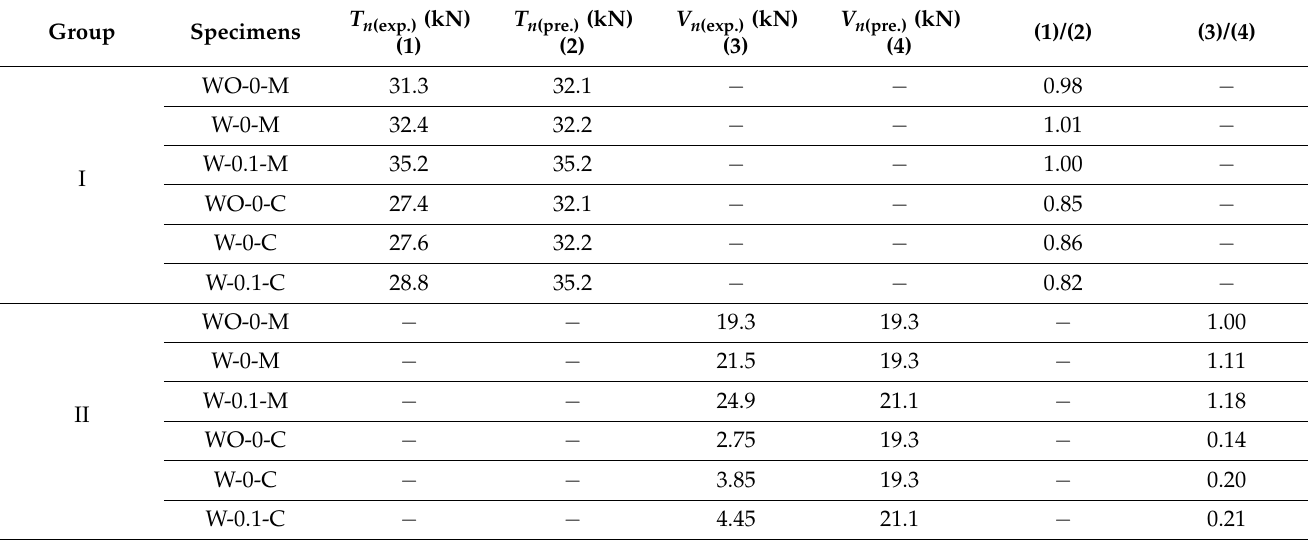
Table 5. Summary of the comparison of measured and predicted axial and shear